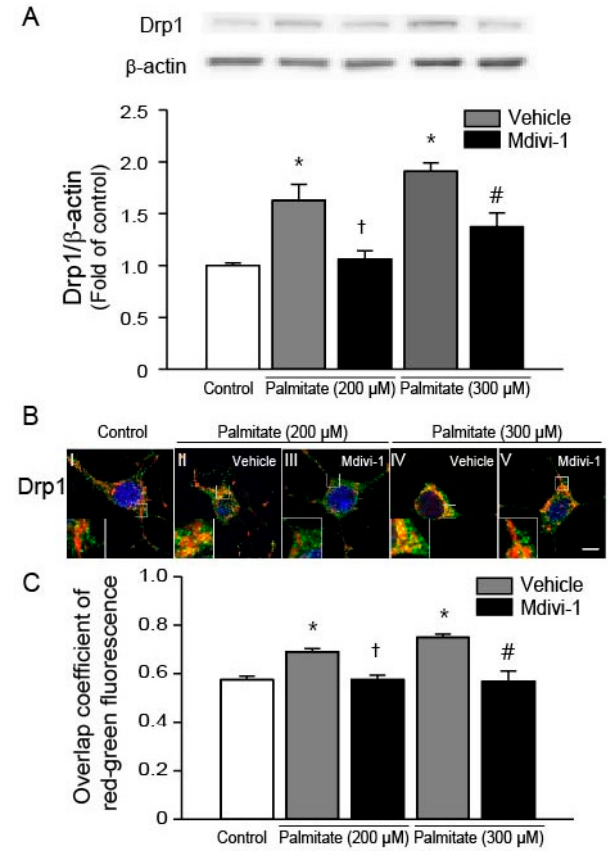
Figure 2. Mdivi-1 inhibits palmitate-induced Drp1 expression and mitochondrial translocation. ( A ) Drp1 protein levels were assessed by Western blot. Drp1 band intensity was normalized to β -actin intensity. ( B ) Effect of mdivi-1 on Drp1 translocation from the cytosol to the mitochondria. At the completion of palmitate exposure, cells were stained with MitoTracker ® Orange CMTMRos (red) and then probed with Drp1 antibody (green) to detect subcellular localization of Drp1. Nuclei were visualized by staining with DAPI. Representative microscopic images show immunofluorescent detection of Drp1. Scale bar = 5 μ m. ( C ) Quantitative analysis for overlap coefficient of red-green fluorescence. Values are the mean ± SEM of four separate experiments performed in triplicate. * p < 0.05 vs. DMSO-treated control; † p < 0.05 vs. 200 μ M palmitate; # p < 0.05 vs. 300 μ M palmitate.